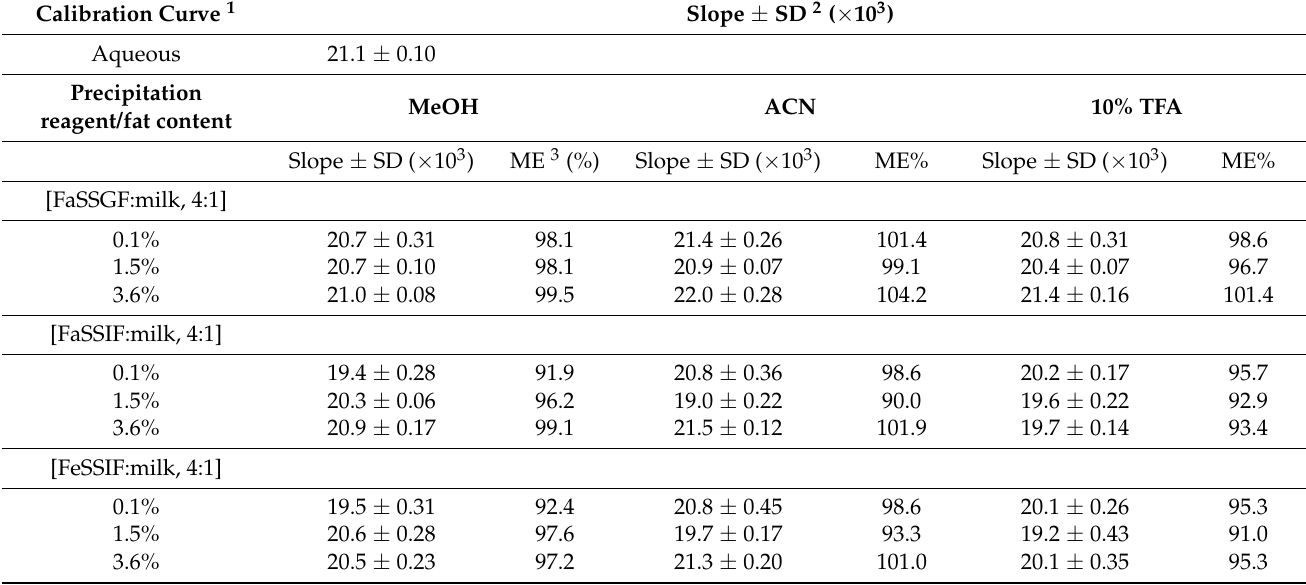
Table 1. Comparison of precipitation reagents (MeOH, ACN, 10% v/v TFA) on the matrix effect. Calibration Curve 1